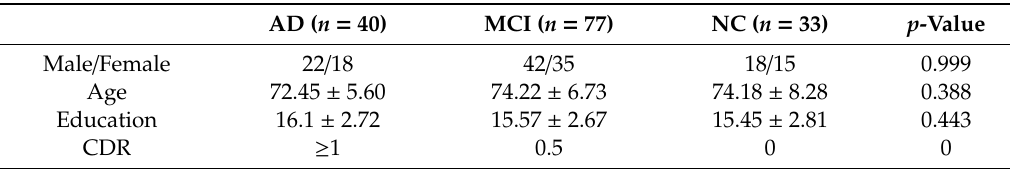
Table 1. Demographic information of the subjects.